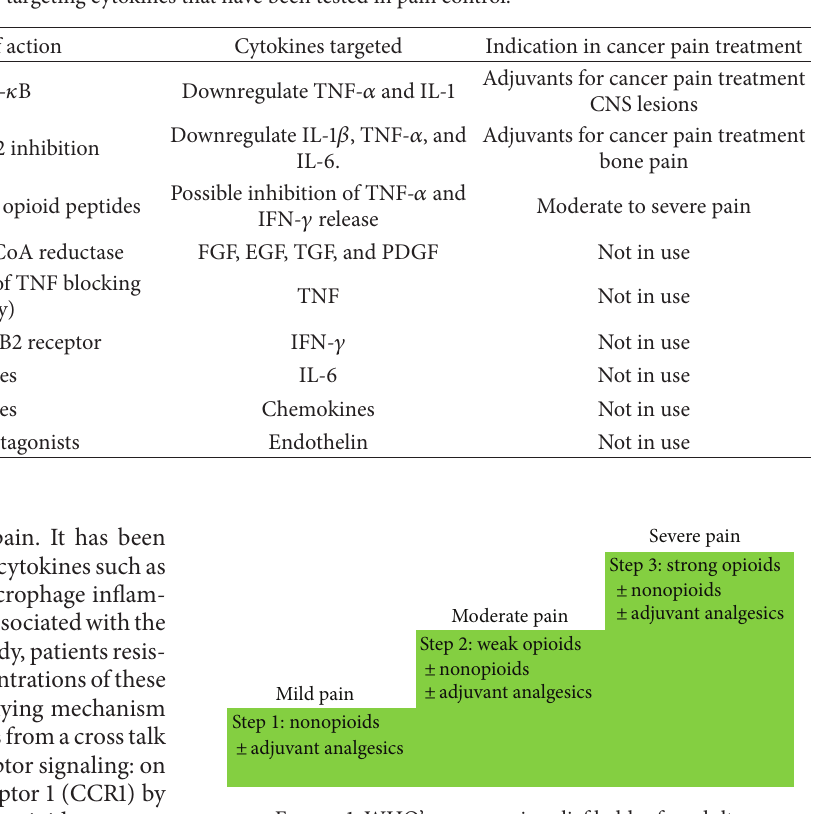
Figure 1: WHO’s cancer pain relief ladder for